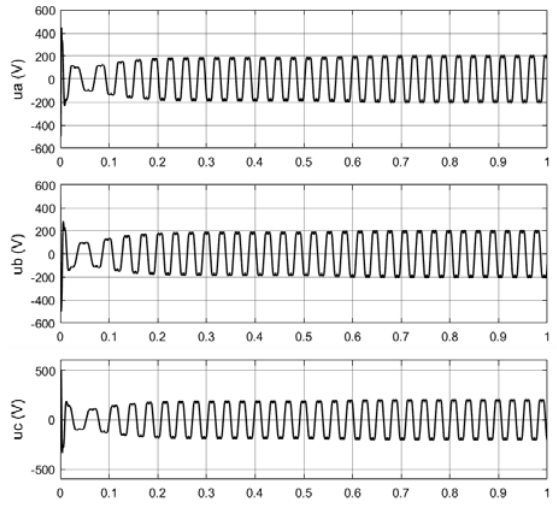
Fig. 4. Input signals for inverter